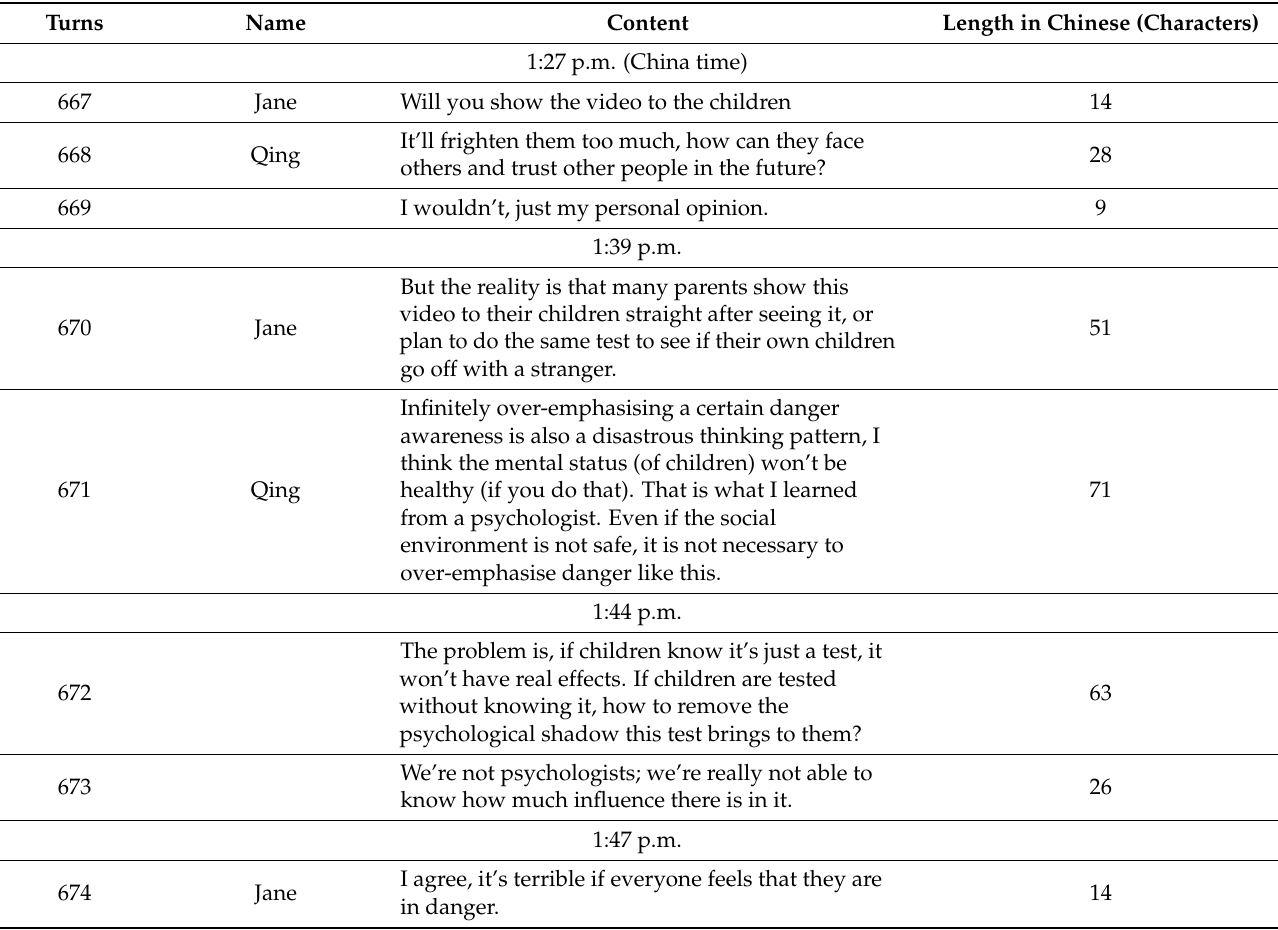
Table 5. Conversation Extract 1 (Information in the brackets is added by researchers to aid under- standing of the